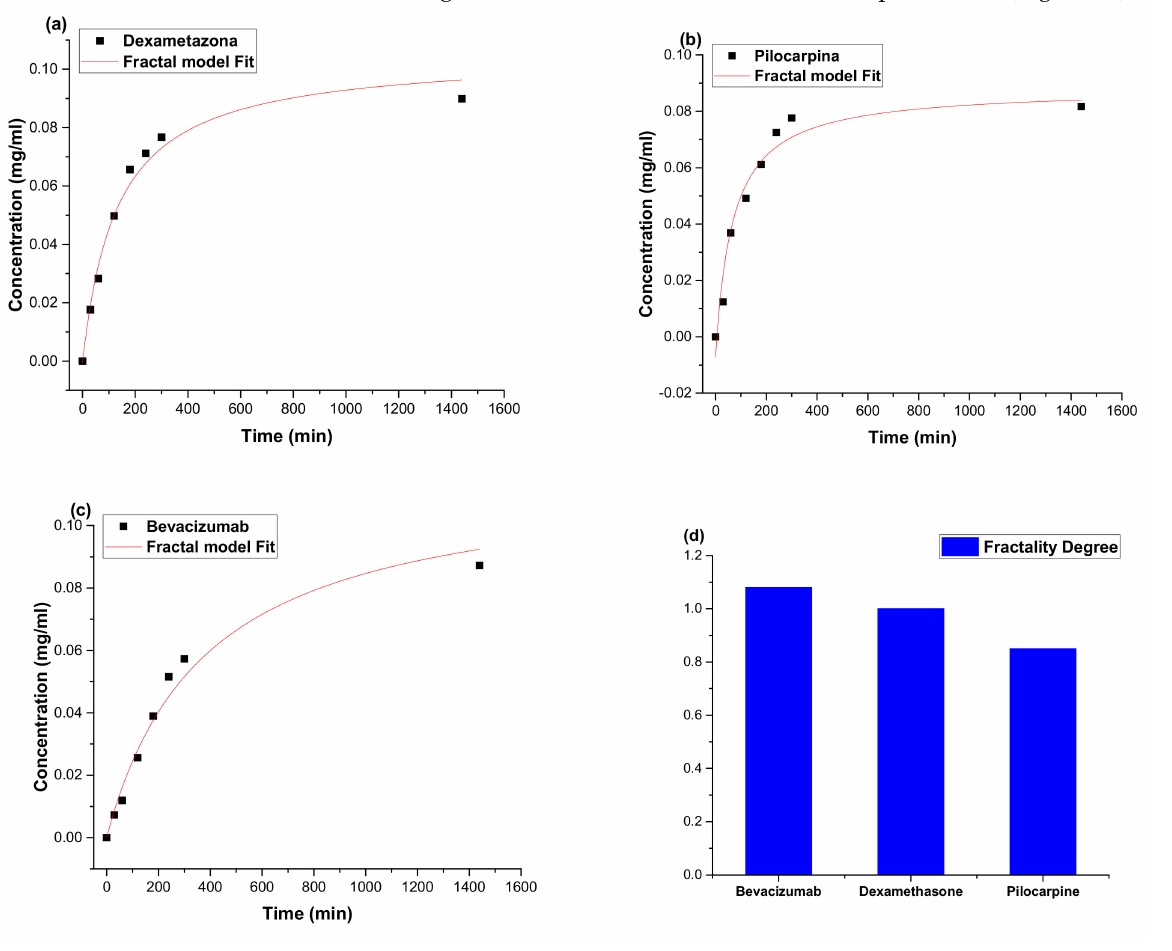
Figure 12. Theoretical fitting of the empirical data and an estimation of the fractality degree for each drug investigated ( a – c ) and the fractality degree evolution with the nature of the drug ( d ). The complexity of particle–drug system generates a complex release profile for